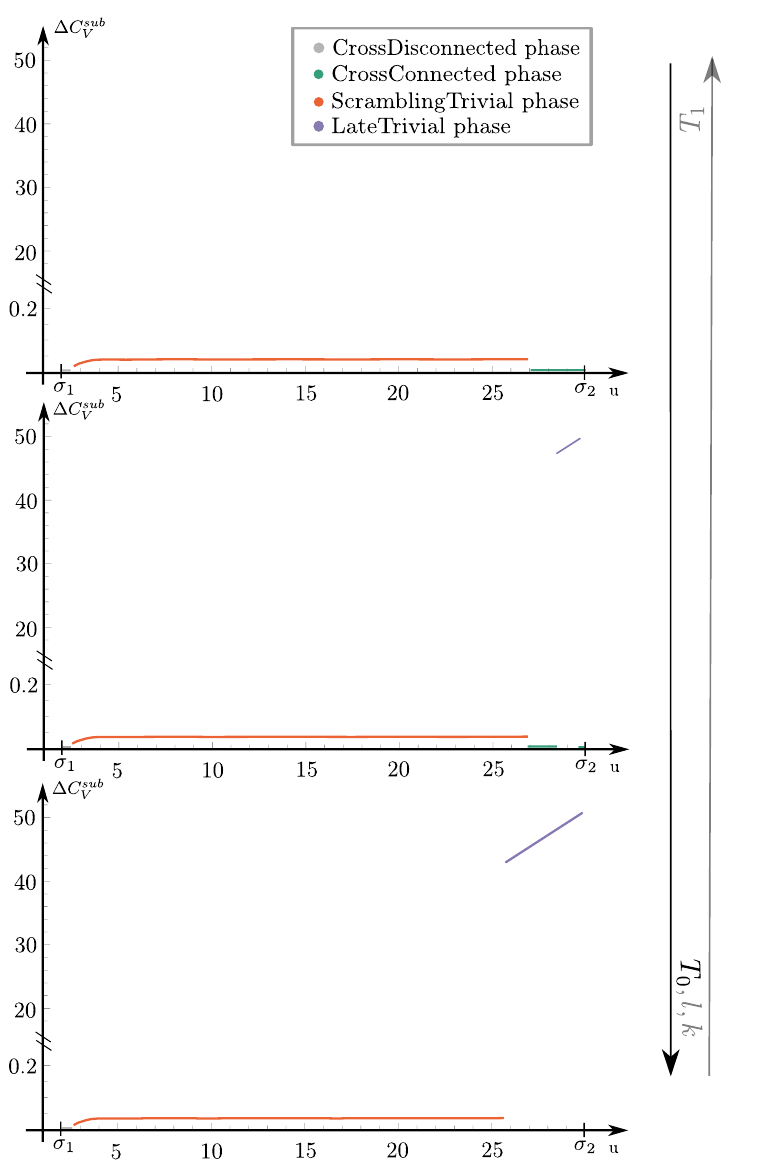
Figure 20. This figure shows the evolution of sub-region complexity at intermediate for QM L +finite segment of radiation in the bath depending on the values of the free parameters in the theory. Specifically, we used different values of T 0 . Namely, we used T 0 = 449 for the upper plot, 512 π T 0 = 453 , 5 for the middle plot and T 0 = 459 for the lower plot, in order to illustrate the different 512 π 512 π scenarios. The values of the other parameters used in this plot can be found in table 2. We have set ‘ = L AdS /G N